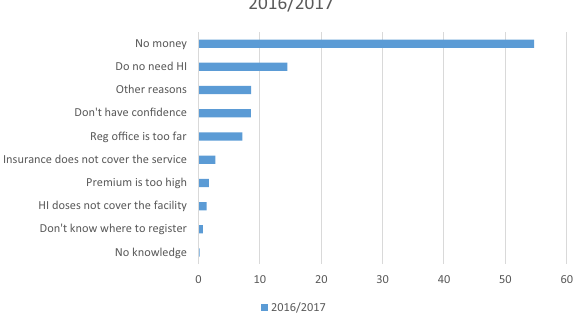
Fig. 3 Reasons why some respondents have never registered. About 48% of the respondents are not insured, citing various reasons. This Figure depicts the percentages of the various reasons given for not enrolling.